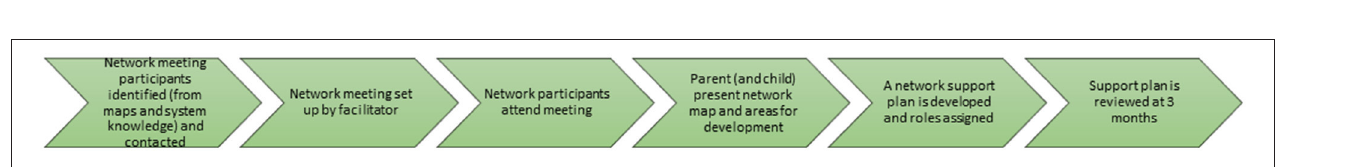
FIGURE 6 | Practical elements of CVA Phase